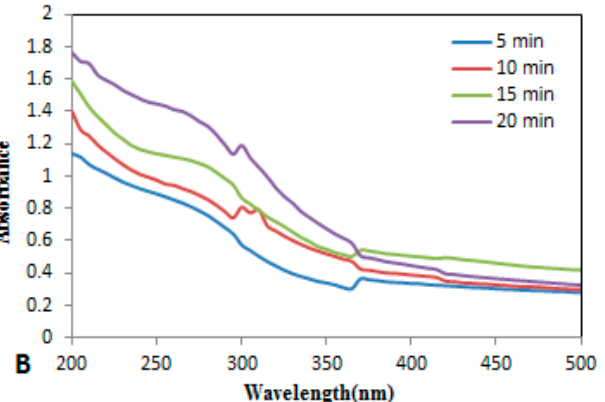
Figure 2. UV–Vis absorption of TiO 2 NP solution synthesized at different ( A ) laser pulse energies and ( B ) ablation times.